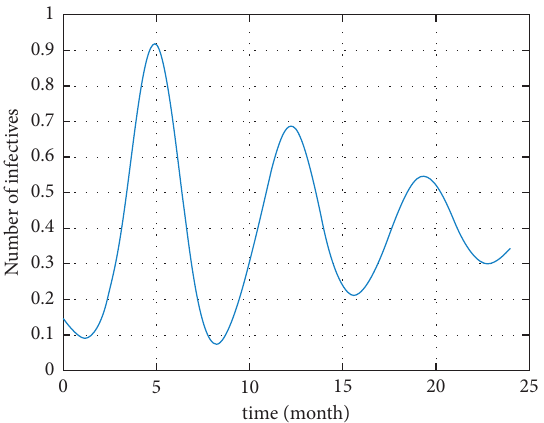
Figure 6: Proportion of the infective from March 2020 to January